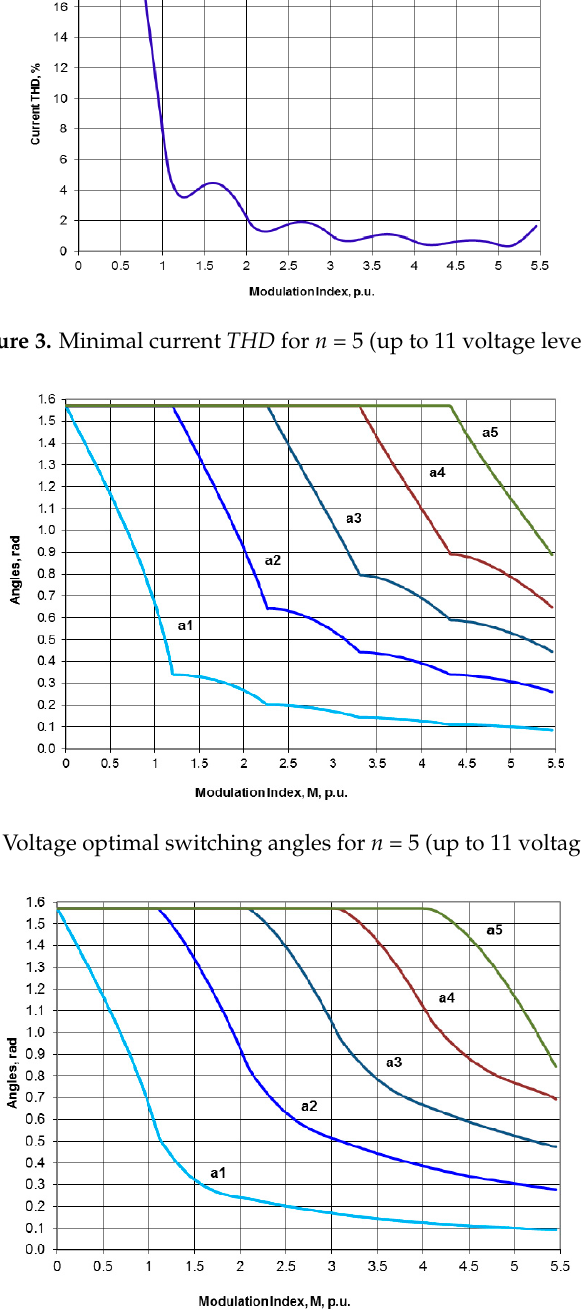
Figure 5. Current optimal switching angles for n = 5 (up to 11 voltage levels).